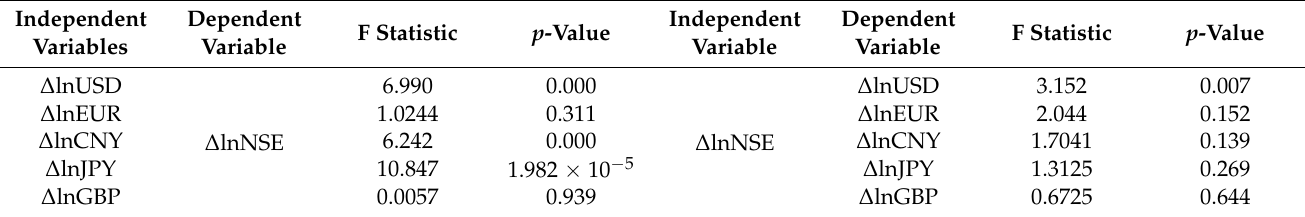
Table 7. Granger causality in VAR Framework for the period January 2005–December